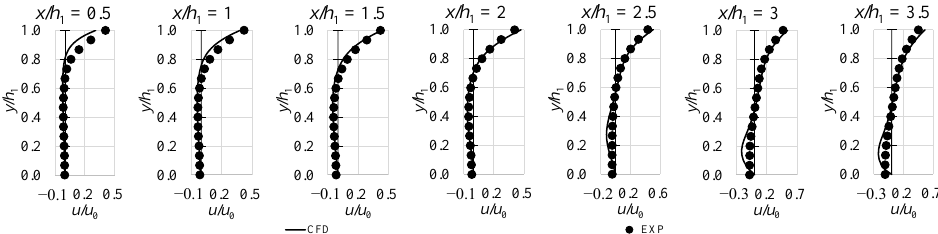
Figure 5. Numerically and experimentally obtained velocity u profiles at Re = 1000.